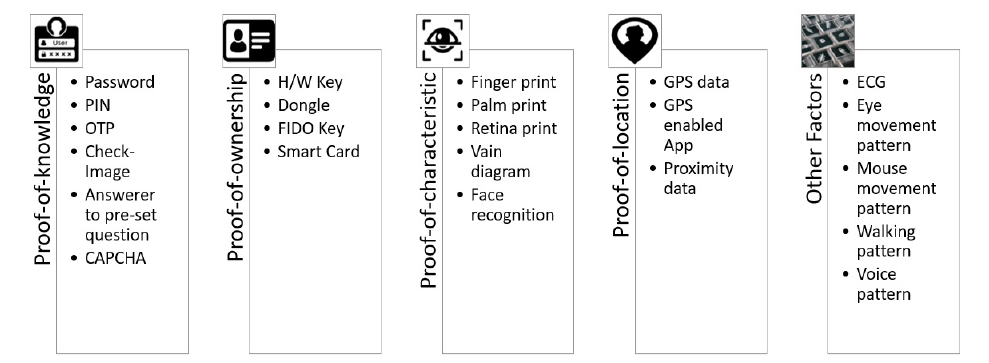
Figure 4. Various Authentication